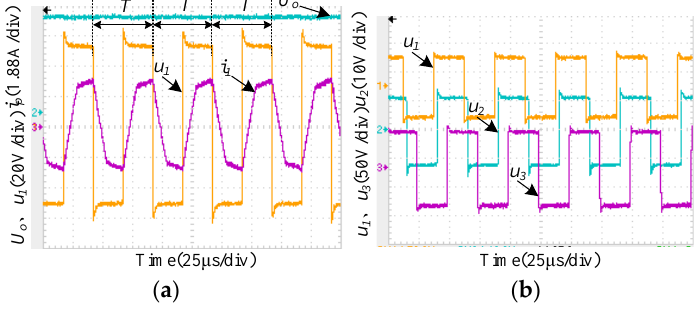
Figure 21. Measured waveforms of shifted-phase angle control using fixed switching-frequency: ( a ) converter voltage, current of port 1 and output voltage of port 2; ( b ) converter voltages of port 1, 2 and 3.